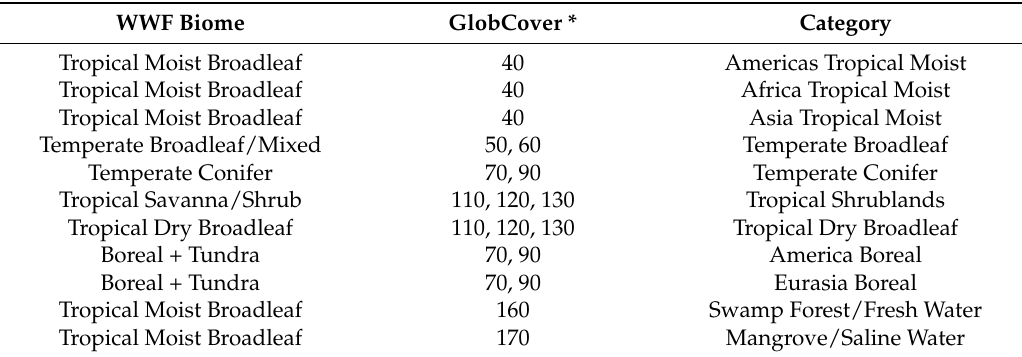
Table 1. List of combination of World Wildlife Fund’s (WWF) biome and GlobCover landcover type used to determine forest categories that GLAS LiDAR shots belong